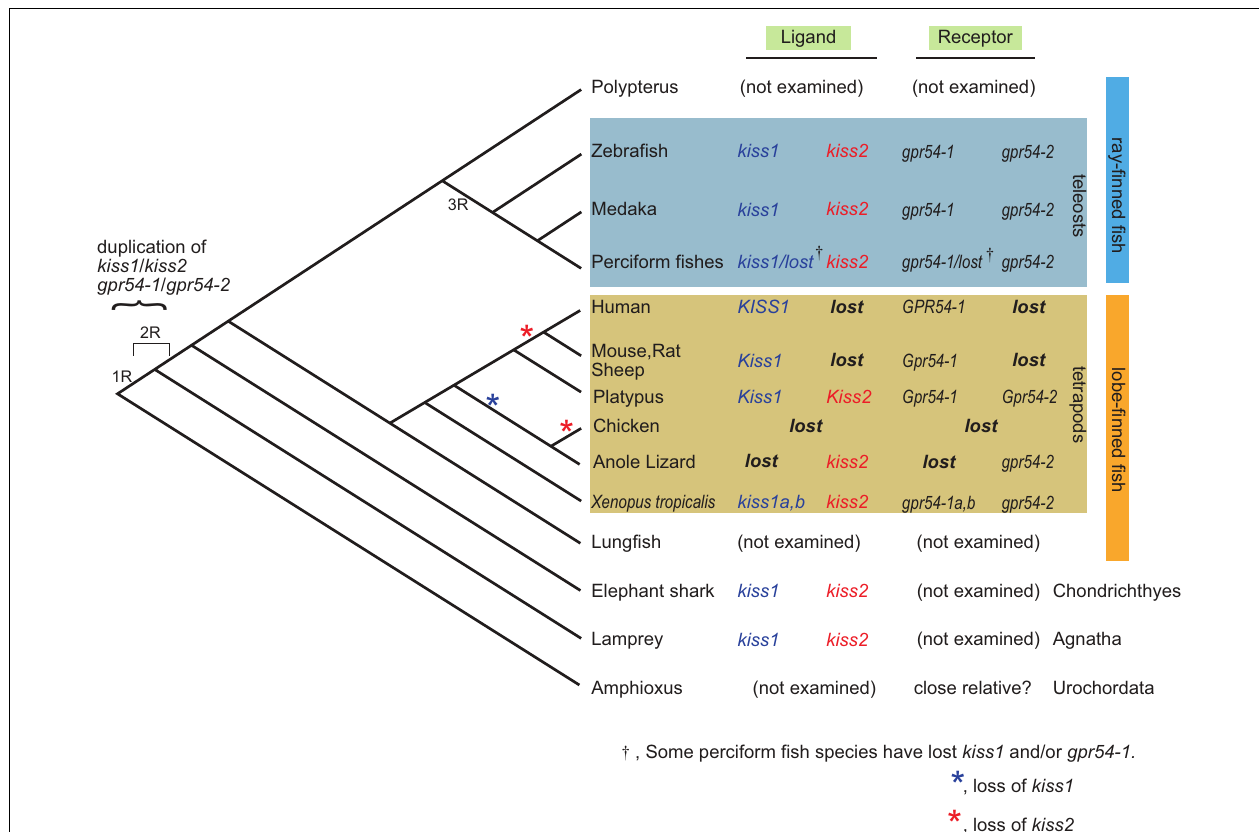
evolution. It should be noted that some teleost species have lost gpr54-1 , but no teleosts have lost gpr54-2 , suggesting the significance of gpr54-2 in teleosts, which is opposite to the case in the mammalian lineage. It is also consistent with the higher level of expression of gpr54-2 compared to that of gpr54-1 in teleost brains.The loss of kiss1 (blue) or kiss2 (red) is indicated by